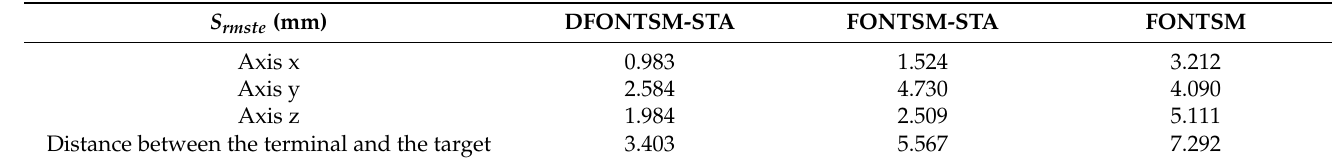
Table 14. Terminal root mean square error of the humanoid